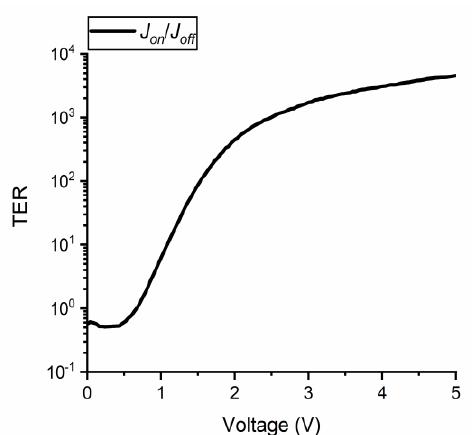
Figure 7. Tunnel electro-resistance (TER) as a function of the applied DC bias voltage.